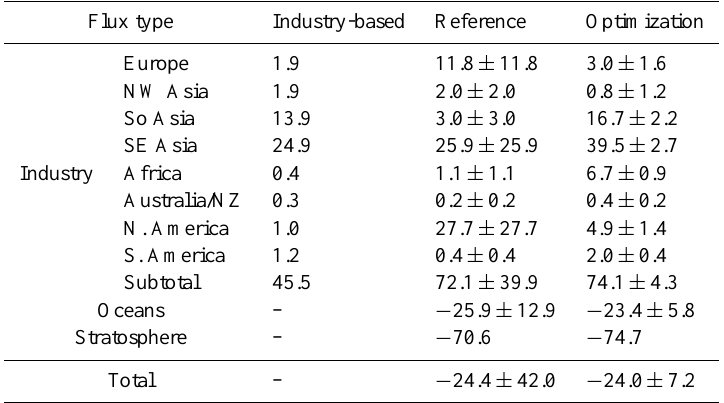
Table 2. Nine-year averaged optimally estimated surface fluxes and their errors for the industrial sources and oceanic sink of CCl 4 (units are Ggyr − 1 ) . Also shown is the nine-year average stratospheric sink in the forward runs using the reference and optimally estimated industrial emissions and oceanic sink.